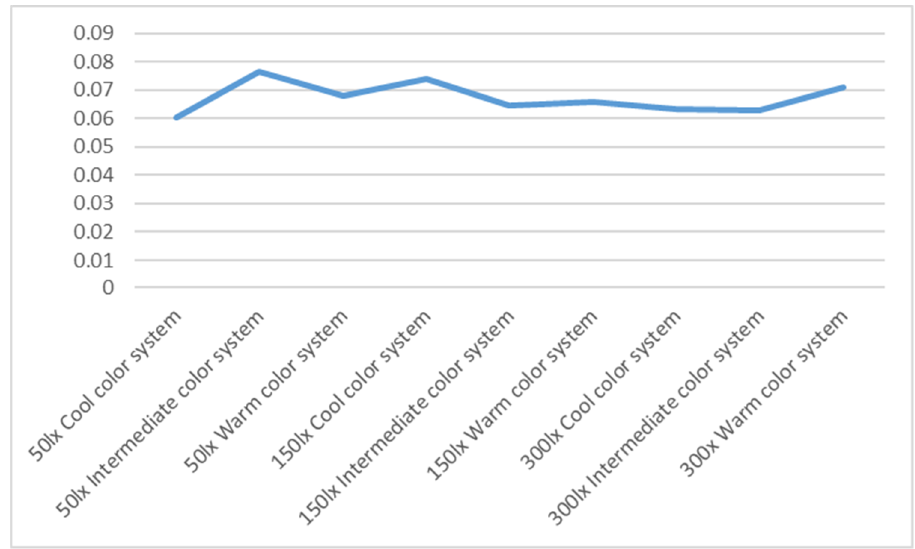
Figure 10. Mean value of coefficient of variation of pupil diameter under nine conditions.